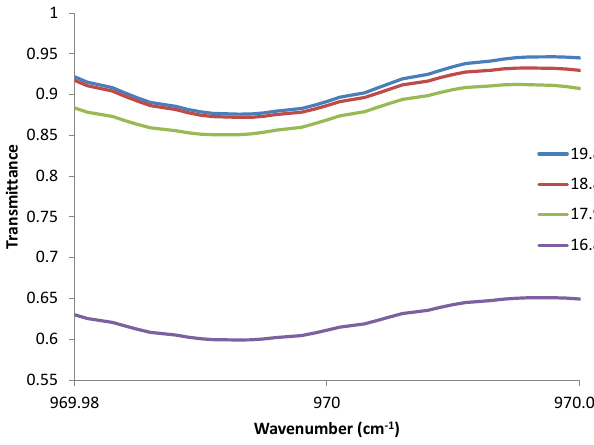
Figure 1. Temperature dependence of N 2 CIA determined using the empirical model of Lafferty et al. (1996). The pink squares were determined in this work, while previous attempts were made by Hartmann (Lafferty et al., 1996) in blue-grey and Foucher (2009) in dark blue using the same data set. Also shown in green is the temperature-dependence model parameter determined here using the less precise measurements of Menoux et al. (1993).